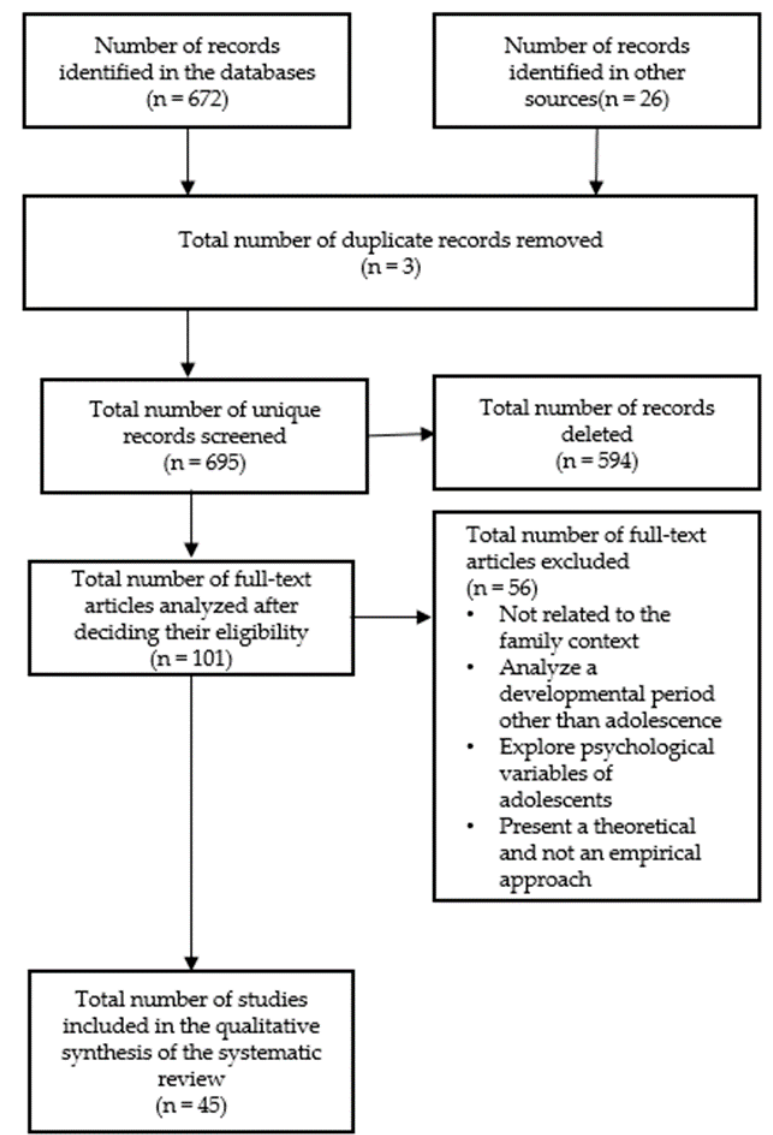
Figure 1. PRISMA flow diagram of the study selection process.